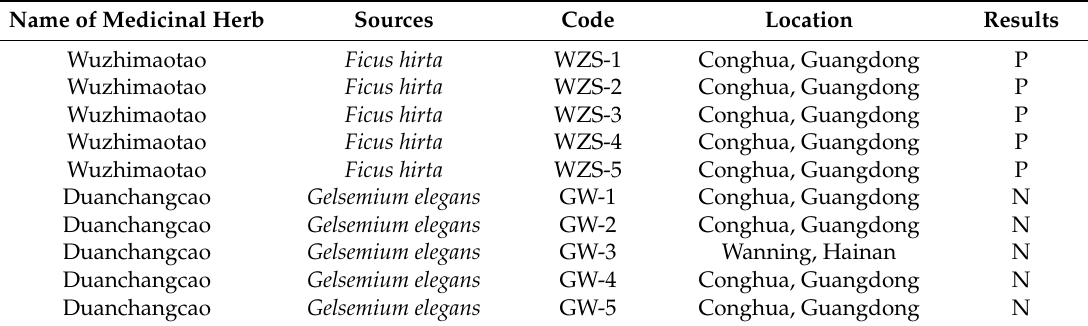
Table 1. Sample information and results obtained for the specificity of the BAR-RPA primers.